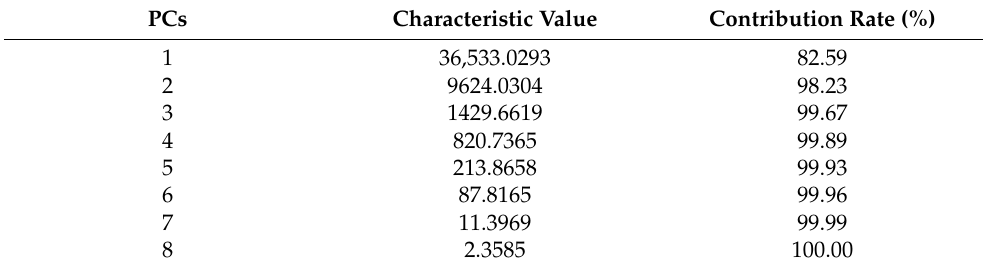
Table 4. The cumulative contribution rate of the first eight principal components of the image.